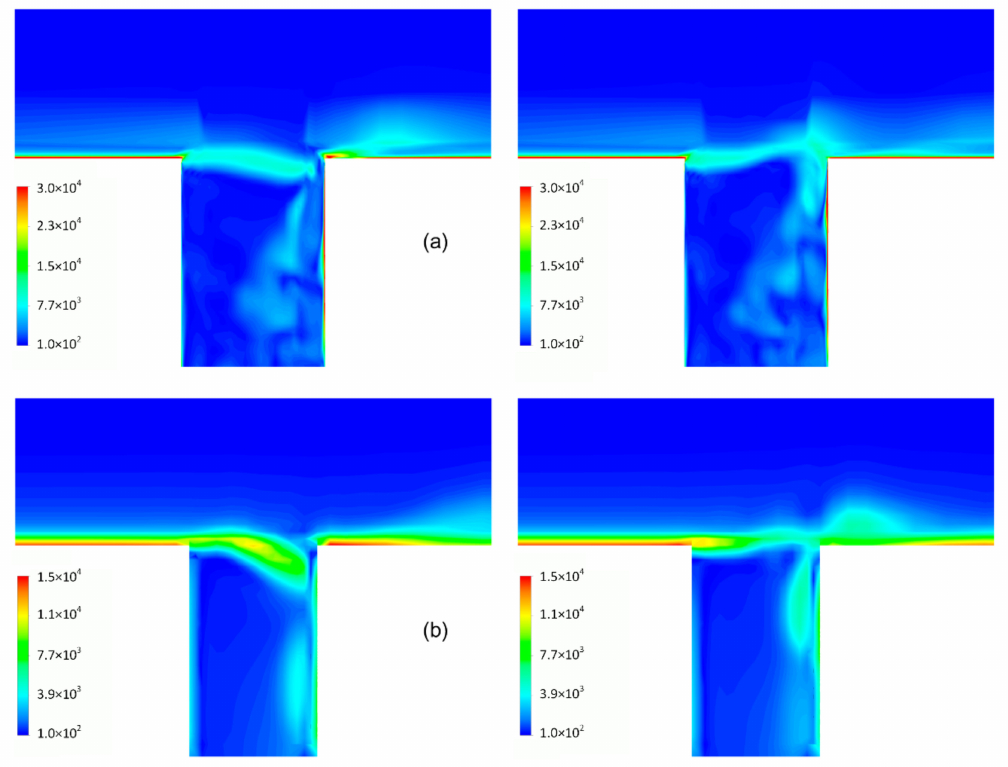
Figure 8. The vorticity (unit: s − 1 ) at the peak pressure value ( left ) and the nadir pressure value ( right ) of the circular section pipe ( a ) and the equivalent square section pipe ( b ), St =